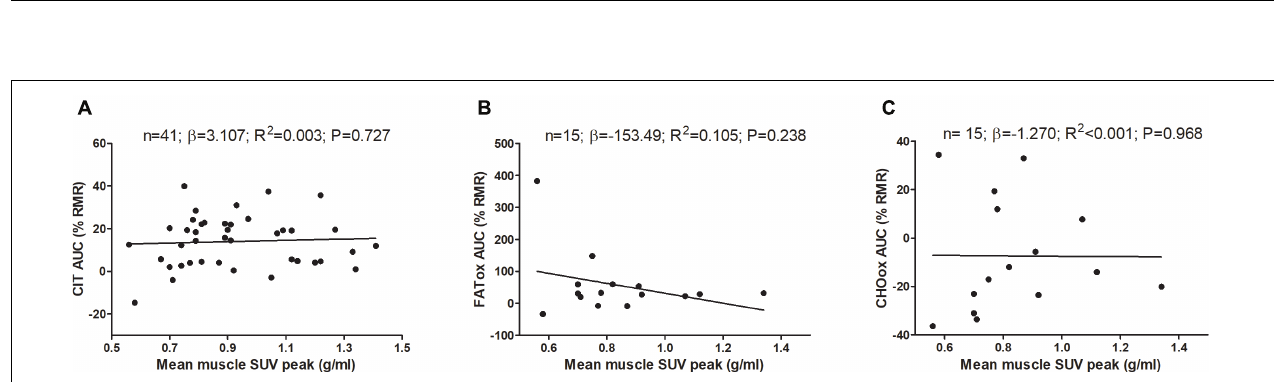
FIGURE 2 | Association of skeletal muscle 18 F-FDG activity after a personalized cold exposure with cold induced thermogenesis (CIT) and cold-induced nutrient oxidation rates (Study 1). Skeletal muscle 18 F-FDG activity represents an average of the uptake in several skeletal muscles: paracervical muscles (cervical vertebrae 4), sternocleidomastoid, scalene, longus colli, trapezius, parathoracic muscles (Thoracic vertebrae 2), supraspinatus, subscapularis, deltoid, pectoralis major, and triceps brachii. Unstandardized simple regression coefficient ( β ) and standardized coefficient of determination (R 2 ). SUV: Standardized uptake value; AUC: Area under the curve; RMR: Resting metabolic